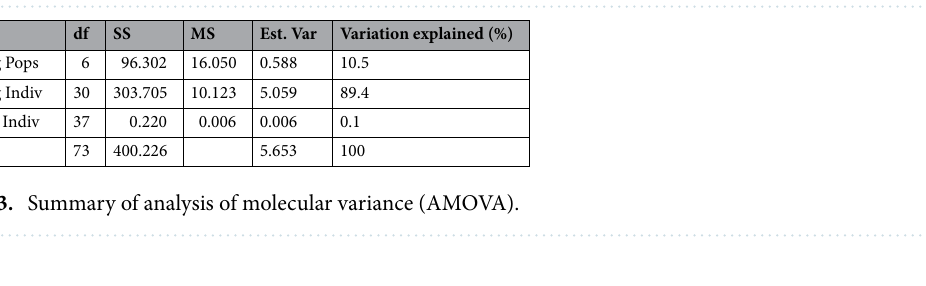
Figure 2. Results of the principal coordinates analysis of 17 microsatellite loci in S. wightiana (DARwin ver. 6.0; http:// darwin. cirad. fr/ darwin).